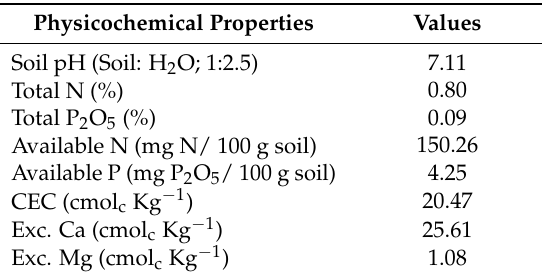
Table 2. Physicochemical properties of peat soil.